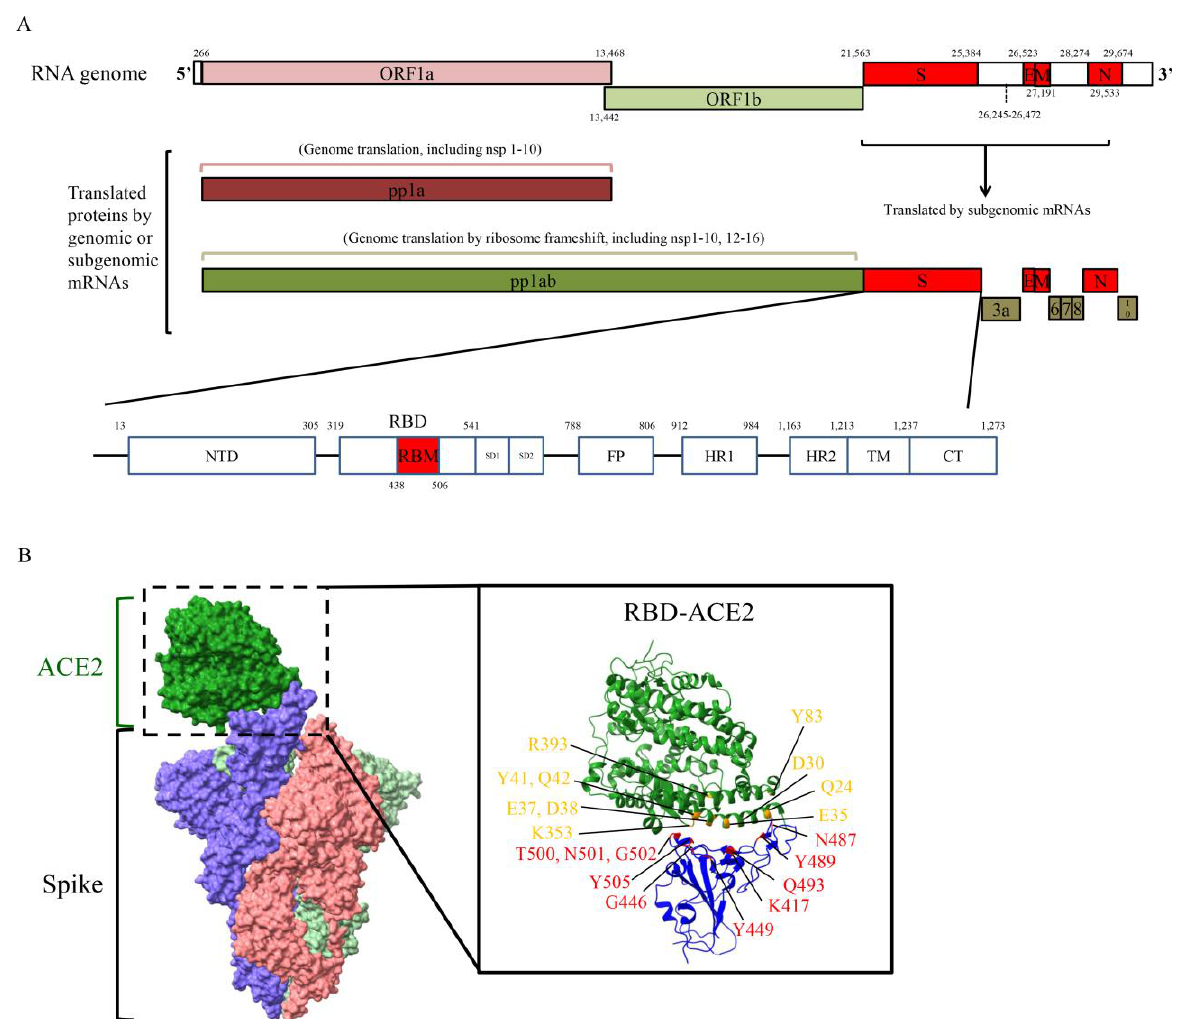
Figure 1. Severe acute respiratory syndrome coronavirus 2 (SARS-CoV-2) genomic organization and structure of S glycoprotein. ( A ) The ORF1a and ORF1b genes can be translated to polyprotein 1a (pp1a) and polyprotein 1ab (pp1ab, -1 ribosomal frameshift). Pp1a and pp1ab can be processed into several functional non-structural proteins (nsps). Structural genes encode four structure proteins, S glycoprotein, envelope protein (E), membrane protein (M), and nucleocapsid protein (N). Several accessory proteins are encoded in the end of genome, include ORF3a, ORF6, ORF7, ORF8, and ORF10. NTD, N -terminal domain; SD1 and SD2, subdomain 1 and 2; FP, fusion peptide; HR1 and HR2, heptad repeat 1 and 2; TM, transmembrane region. ( B ) Structure of SARS-CoV-2 S glycoprotein bound to angiotensin 1-converting enzyme 2 (ACE2). S glycoprotein consists of three S glycoprotein monomers which are shown in blue, pink, and light green. ACE2 is shown in green. The interface of SARS-CoV-2 receptor binding domain (RBD)-receptor binding motif (RBM) and ACE2 is enlarged in right panel. The amino acid positions of RBD and ACE2 responsible for binding are shown in yellow (ACE2) and red (RBD). Structure depicting S glycoprotein bound to ACE2 using PDB: 7A94. Structure depicting RBD bound to ACE2 using PDB: 6VW1. Figures are generated by UCSF ChimeraX